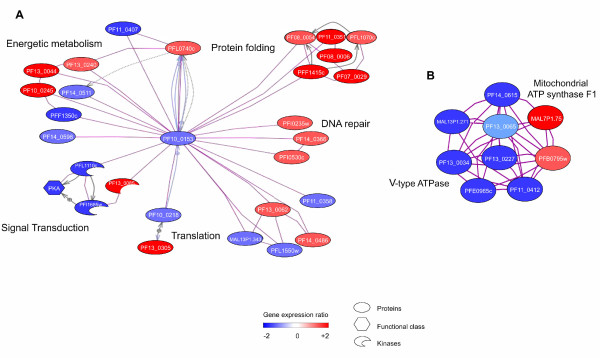
Gene networks involved in the metabolic adaptation to hyperoxia in tightly synchronized P. falciparum cultures. Using PS 6.0™ software and microarray expression data, gene networks were built and genes modulated in response to hyperoxia are represented. (A) Representation of metabolic interrelations related to adaptative hyperoxia exposure. Energetic metabolism: aspartate carbamoyltransferase (P13_0240), carbamoyl-phosphate synthetase (PF13_0044), glutamine-fructose-6-phosphate transaminase (PF10_0245), glucose-6-phosphate dehydrogenase (PF14_0511), acetyl-CoA synthetase (PFF1350c), gapdh (PF14_0598) - Signal transduction: regulatory sub-unit of cAMP-dependent protein kinase (PFL1110c), catalytic sub-unit of cAMP-dependent protein kinase (PFI1685w), ser thr protein kinase (PF13_0085) - Translation: citrate synthase (PF10_0218), translation elongation factor 1 alpha 1 (PF13_0305), proteasome 26S subunit (MAL13P1.343), dihydrolipoamide dehydrogenase (PFL1550w), translation elongation factor 2 (PF14_0486), adaptor-related protein complex 1 (PF13_0062), polymerase RNA I (PF11_0358) - DNA repair: DNA primase (PF14_0366 and PFI0530c), rpa1 (PFI0235w) - Protein folding: ferredoxin reductase (PF11_0407), Hsp10 (PFL0740c), Hsp60 (PF10_0153), Hsp70 (PF11_0351 and PF08_0054), Hsp90 (PFL1070c and PF07_0029), prohibitin (PF08_0006), DnaJ (PFF1415c). (B) Representation of ATP-dependent gene sub-networks altered in hyperoxic conditions. V-type ATPase: V-type ATPase putative (MAL13P1.271), vacuolar ATP synthase subunit h putative (PF13_0034), vacuolar ATP synthetase putative (PFE0965c), vacuolar ATP synthase subunit F putative (PF11_0412), vacuolar ATP synthase subunit D putative (PF13_0227), vacuolar ATP synthase catalytic subunit a (PF13_0065) - Mitochondrial ATP synthase F1: ATP synthase subunit putative (PF14_0615), mitochondrial ATP synthase F1 epsilon subunit (MAL7P1.75), mitochondrial ATP synthase F1 alpha subunit putative (PFB0795w). Red and blue colors correspond respectively to up- and down-regulated genes compared between hyperoxic to normoxic conditions.